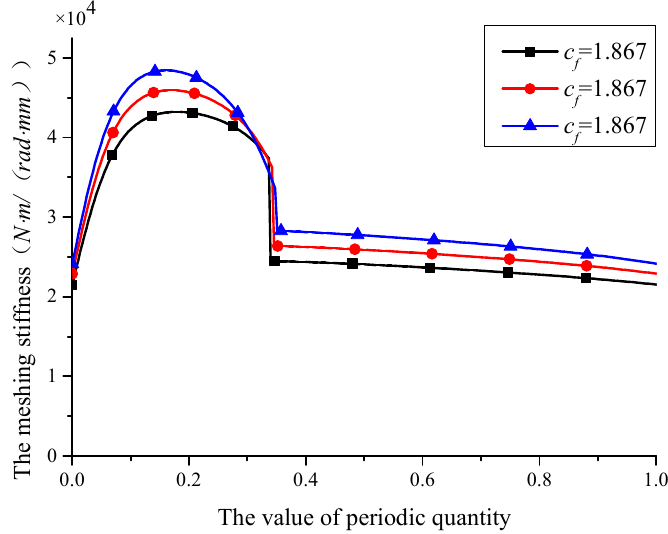
The diameter coefficient of roller pin c f is set as 1.867, 1.917 and 1.967. The results are shown in Figure 28. It can be seen that the c f mainly affects the meshing stiffness. The meshing stiffness in both the single tooth meshing area and the double tooth meshing area increase with the increase of the c f . In addition, the proportion of the double tooth meshing area increases slightly with the increase of the c f .